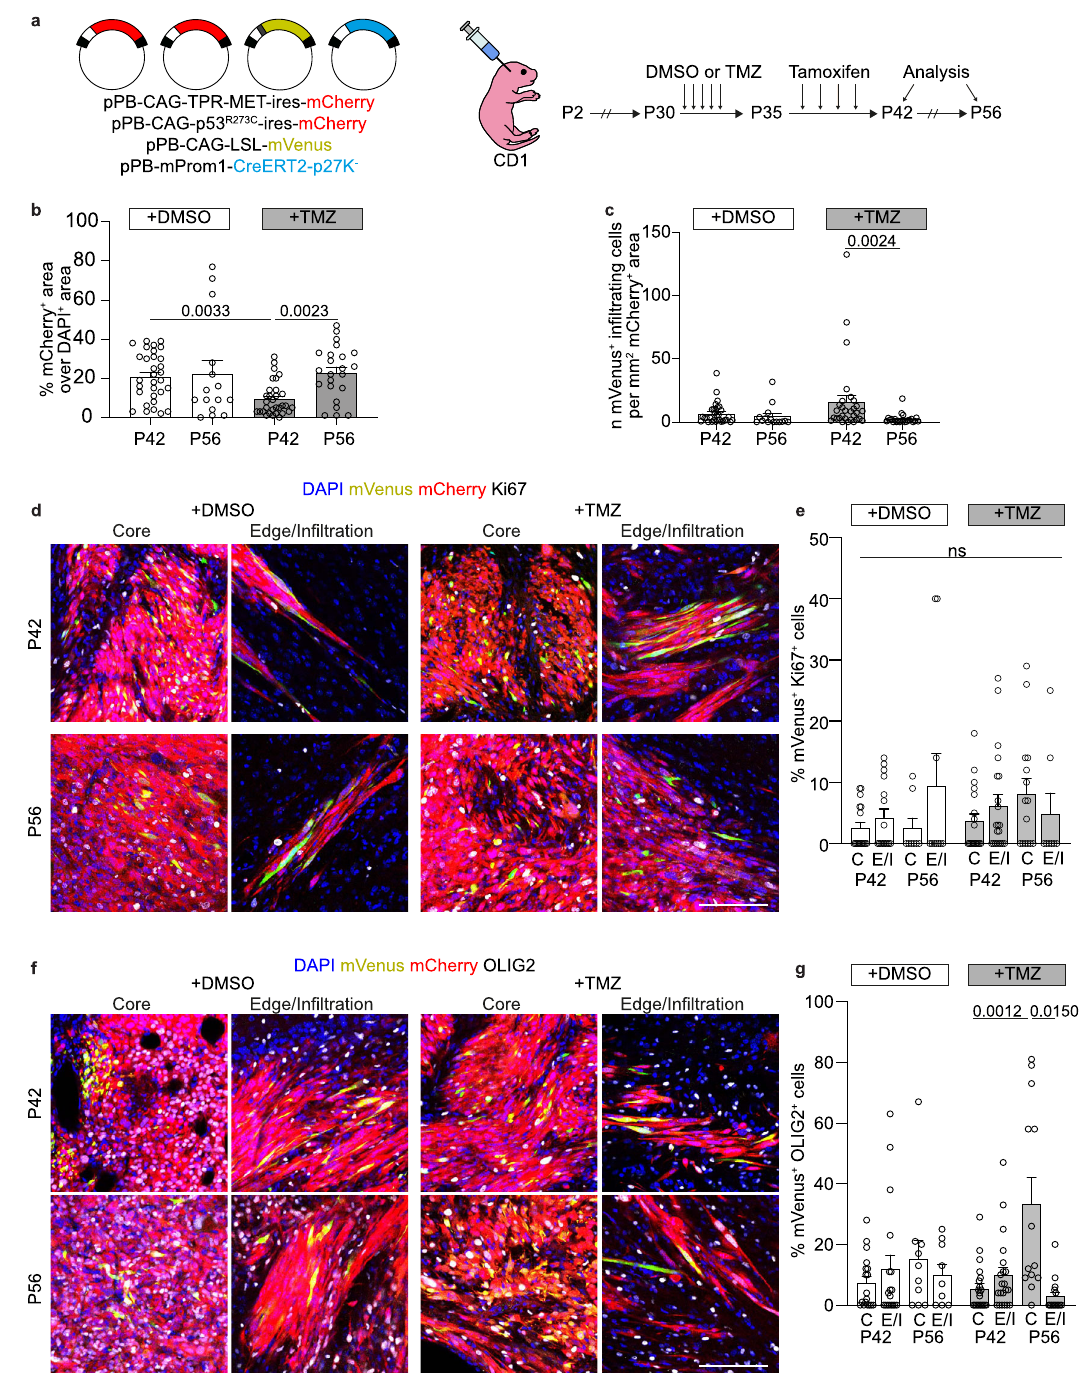
Fig. 3 | Lineage tracing of quiescent Prom1 + cells in TP-induced tumors after Temozolomide treatment. a Electroporation of cells in the SVZ of P2 CD1 mice with pPB-CAG-TPR-MET-ires-mCherry and pPB-CAG-p53 R273C -ires-mCherry toge- ther with pPB-CAG-LSL-mVenus and pPB-mProm1-CreERT2-p27K − . Mice were injected with DMSO or Temozolomide (TMZ) every day from P30 to P34 and then with Tamoxifen every two days from P35 to P41. Brains were dissected at P42 and P56. b Quanti fi cationofthetumorsizeshownaspercentageofmCherry + areaover DAPI + area in brain sections of DMSO- ( n =7 mice at P42; n =3 mice at P56) and TMZ-treated ( n =7 mice at P42; n =5 mice at P56). Each dot represents a brain section. c Quanti fi cation of mVenus + in fi ltrating cells in the tumor of DMSO- ( n =7 mice at P42; n =3 mice at P56) and TMZ-treated ( n =7 mice at P42; n =5 mice at P56).Eachdot representsa brain section. d , e Images( d )and quanti fi cations( e ) of mVenus + cells (green) co-expressing Ki67 (gray) in the core or edge/in fi ltrative